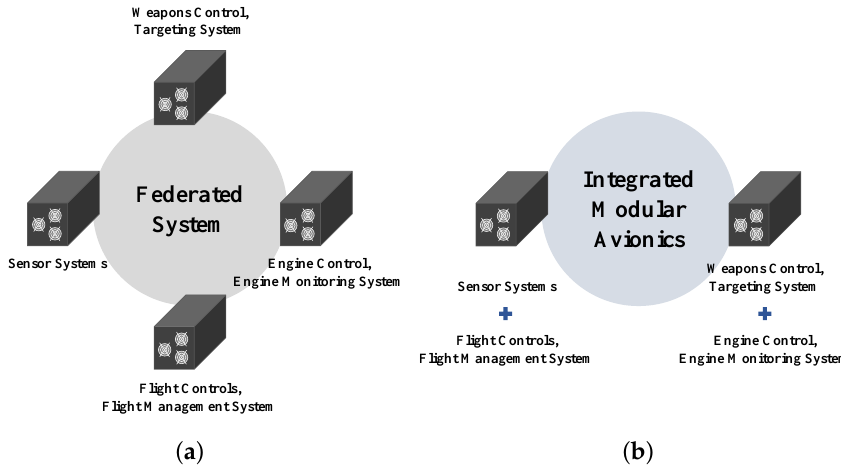
Figure 1. Architectures of the avionics system. ( a ) Federated architecture. ( b ) Integrated modular architecture.